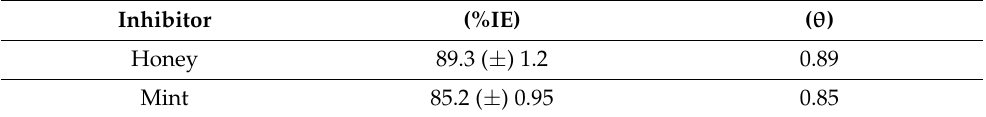
Table 4. Calculated values of (%IE) and ( θ ) by using the Weight Loss method for aluminum in the aqueous solution of inhibitor and 1 M HCl (duration is 2 h). The standard deviation is shown by the ( ± ) sign, and these numbers represent the average of three measurements. Inhibitor (%IE) ( θ ) Honey 89.3 ( ± ) 1.2 0.89 Mint 85.2 ( ± ) 0.95